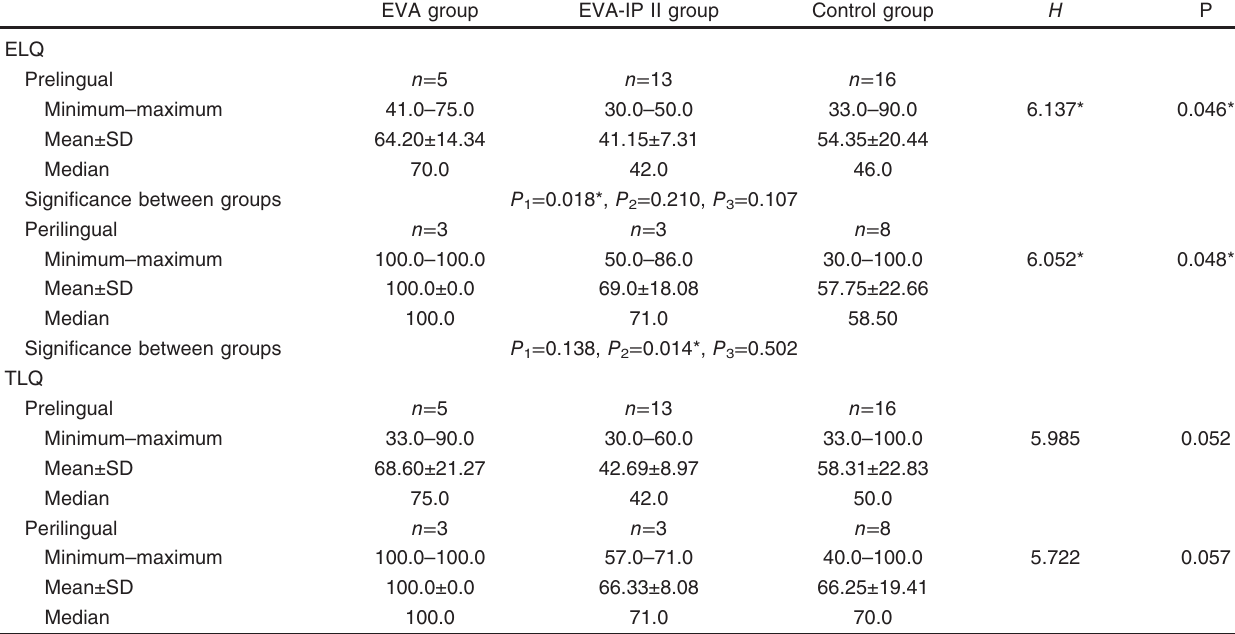
Table 8 Comparison according to expressive language quotient and total language quotient in the three studied